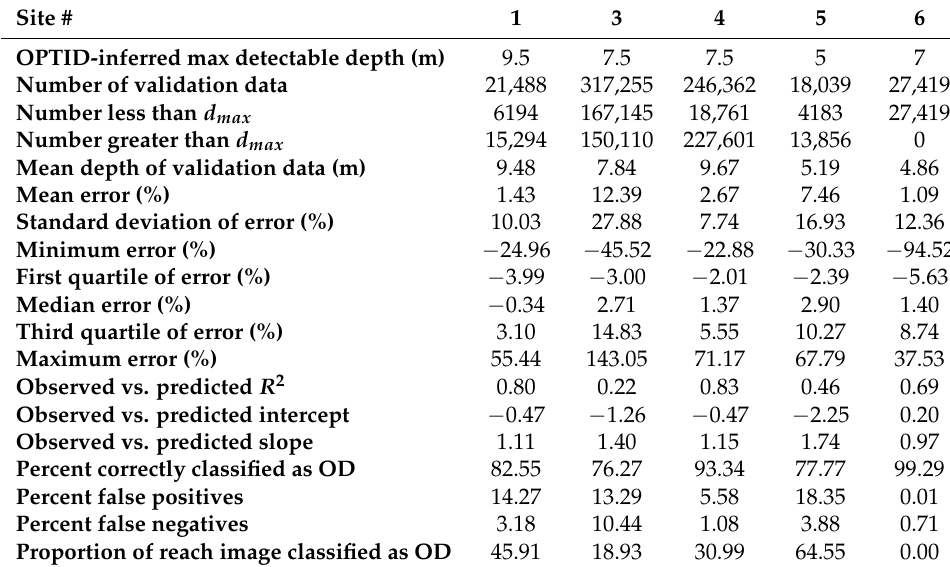
Table 2. Summary statistics for depth retrieval accuracy